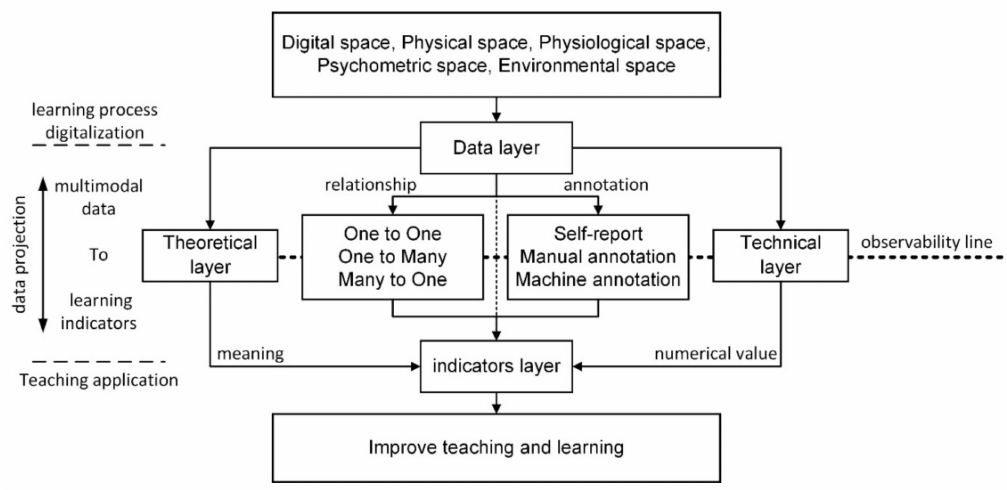
Figure 2. A conceptual model of multimodal data